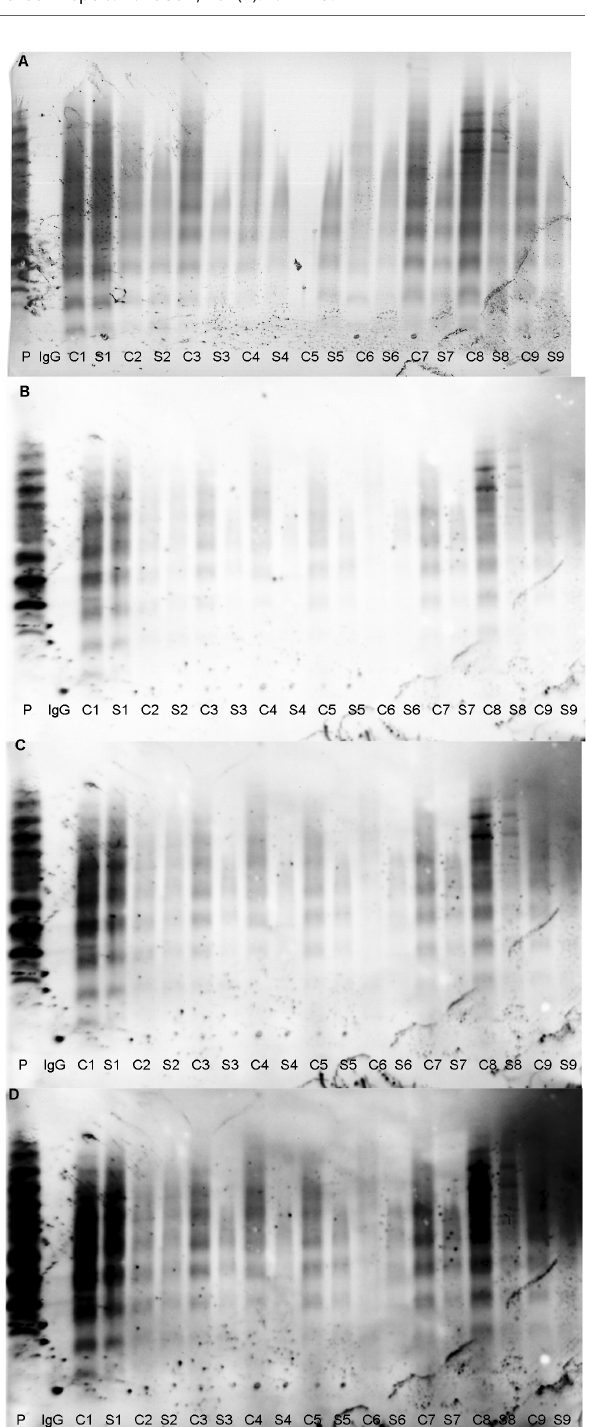
Fig. 2. Oligoclonal IgM. A. BCIP/NBT staining (55 min). B-D. CL detection; exposition times were 33 s (B), 50 s (C) and 90 s